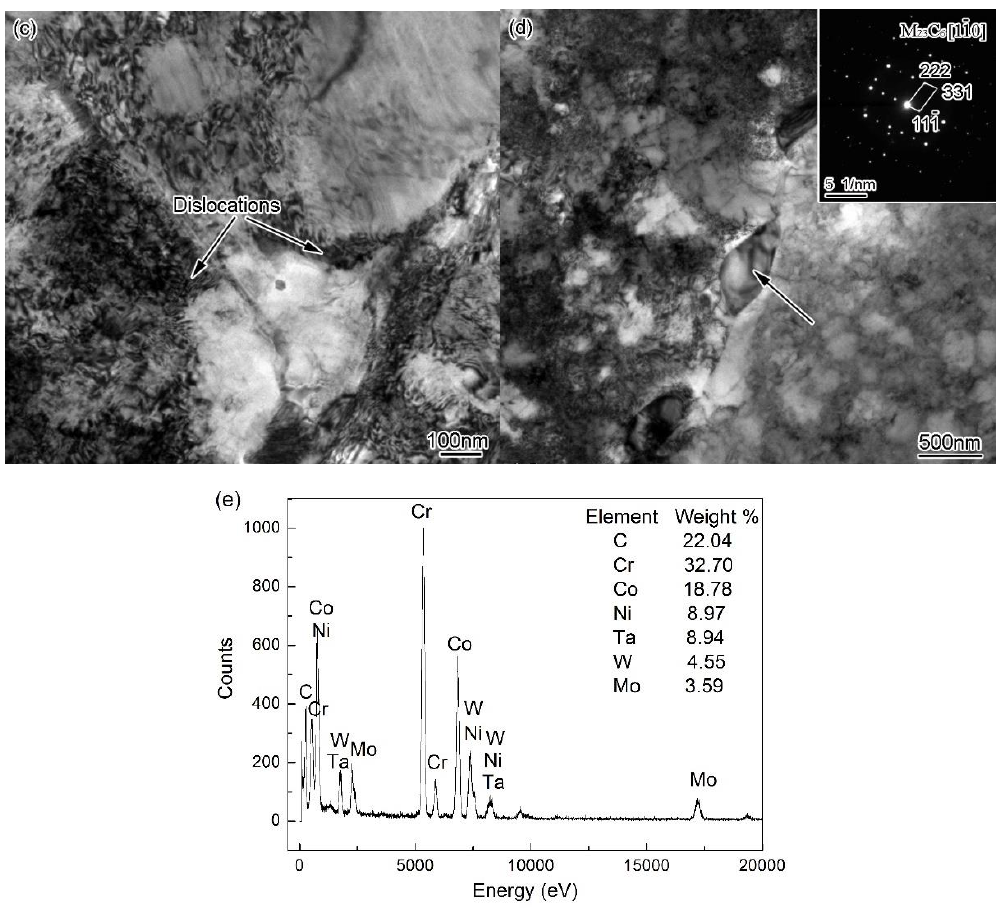
Figure 10. TEM images of dislocation morphology in IFed alloy after creep at 705 °C/897 MPa: ( a ), ( b ), and ( c ) dislocations and stacking faults, ( d ) carbides and selected area electron diffraction (SAED), and ( e ) the energy dispersive spectrometer (EDS) of carbide in Figure 10 ( d ).